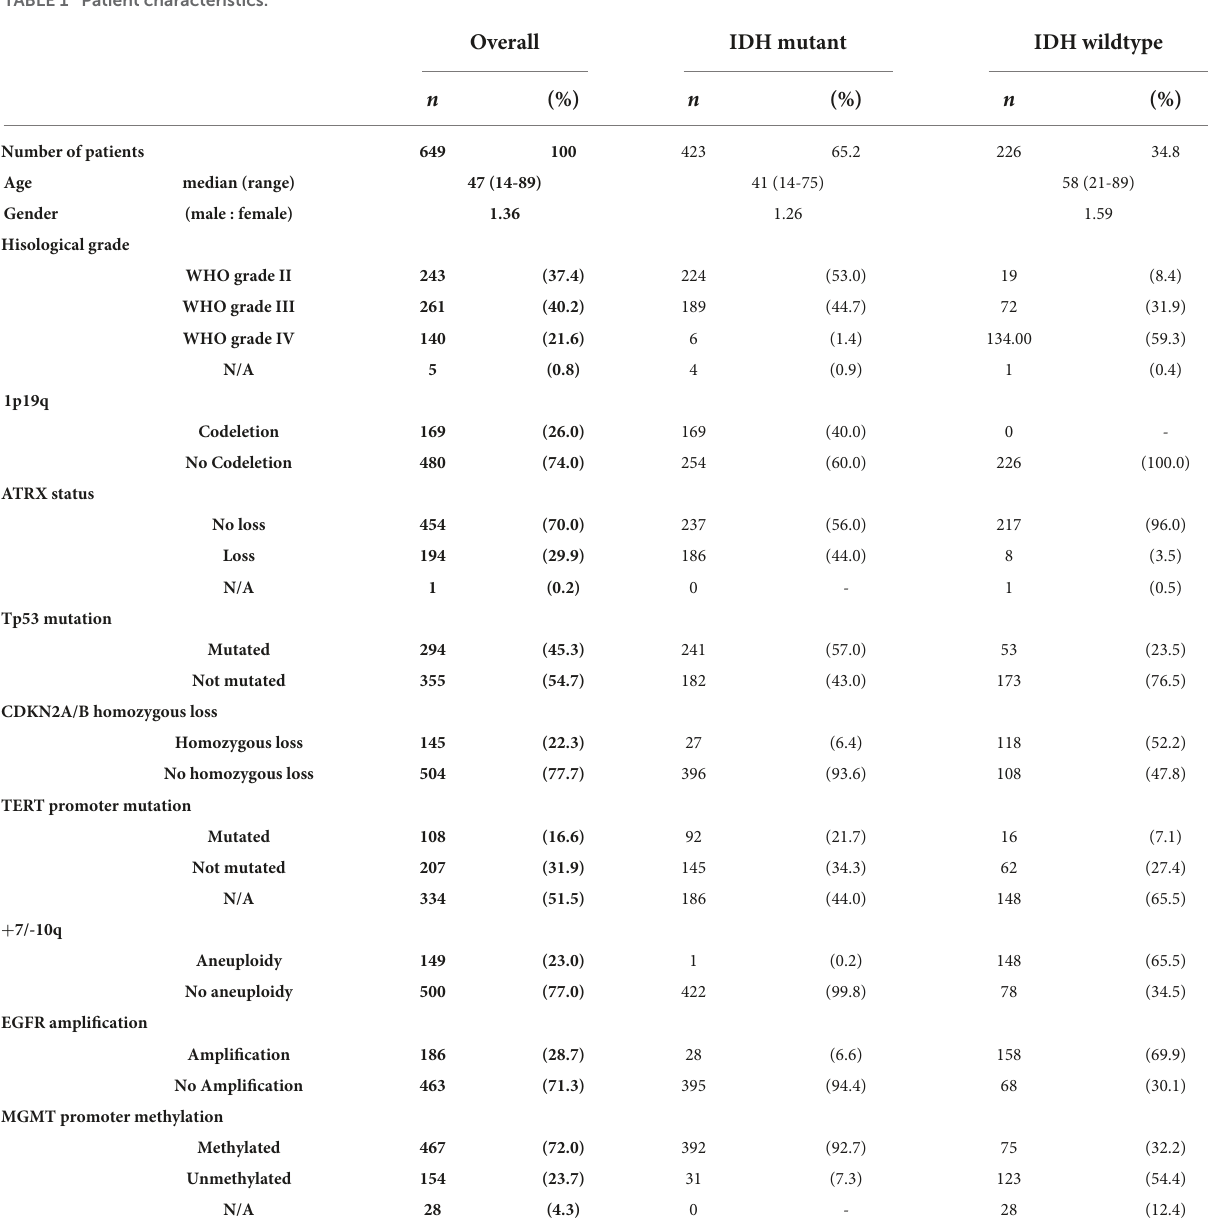
TABLE 1 Patient